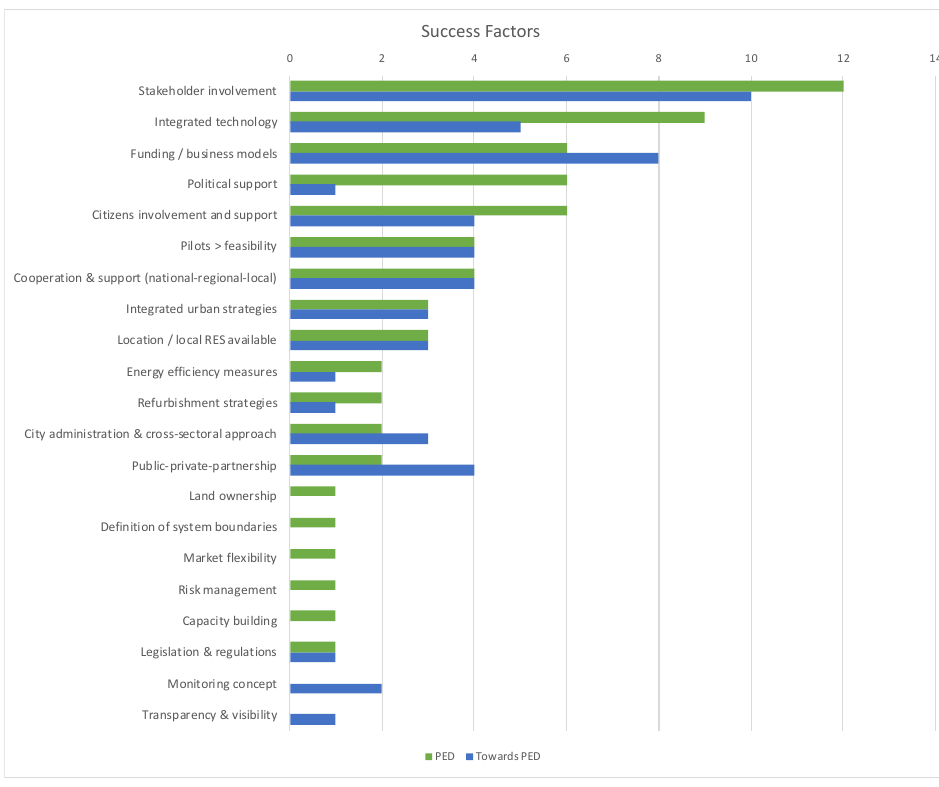
Figure 5. Success factors of implementation of PED and To-PED projects.